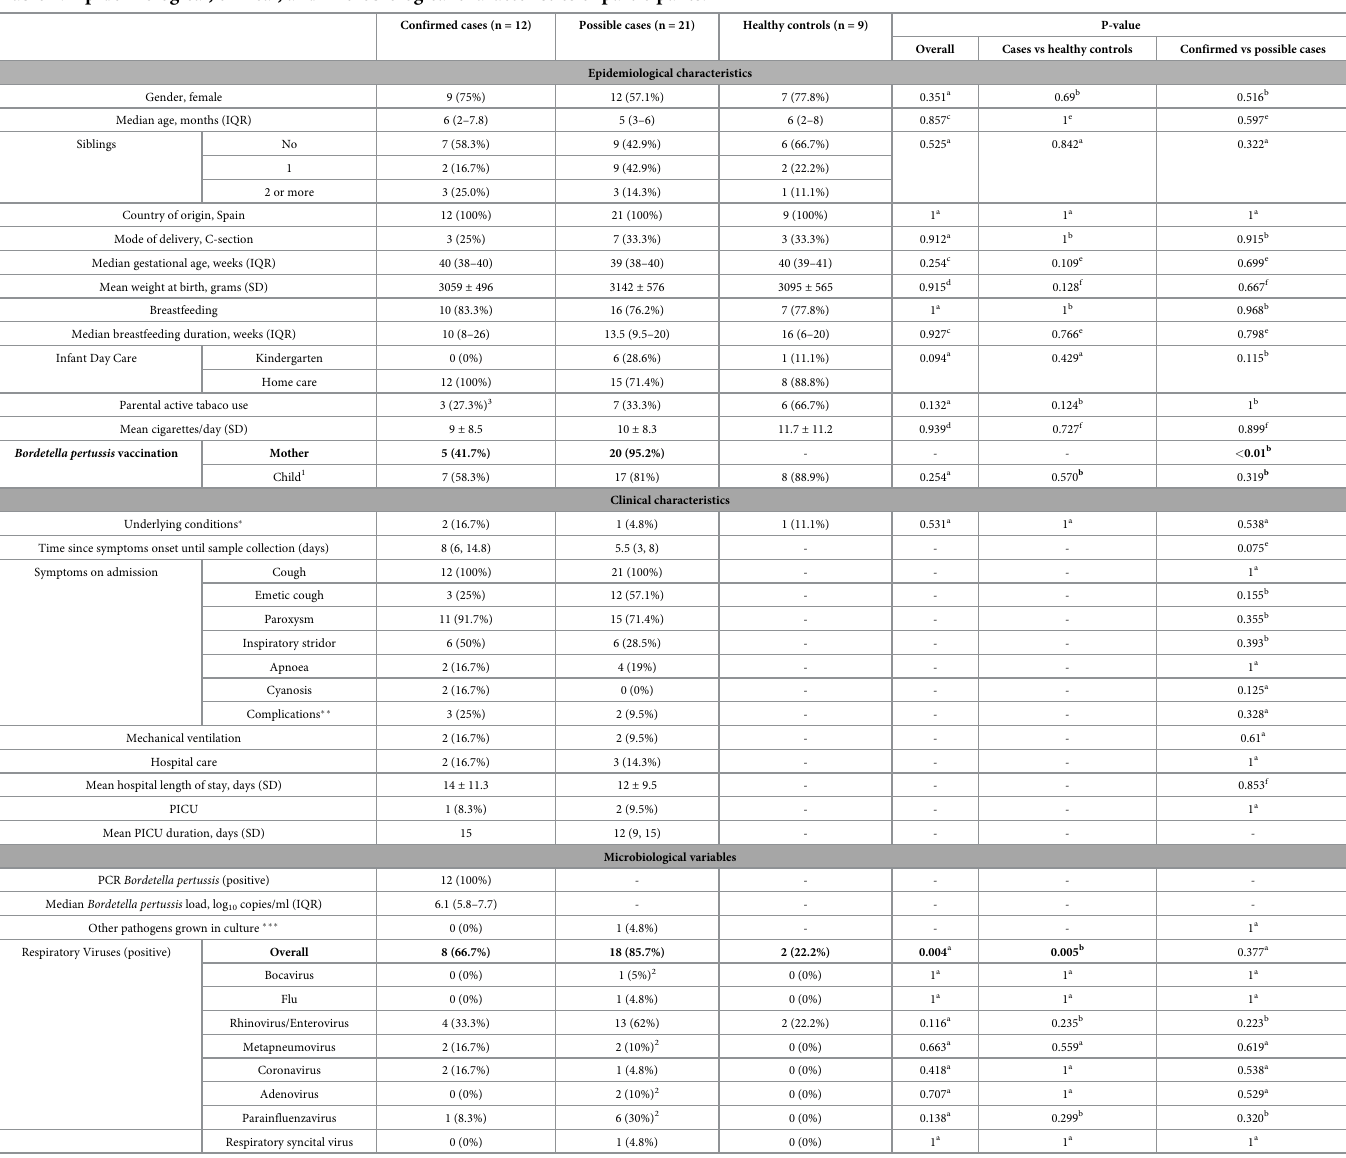
Table 1. Epidemiological, clinical, and microbiological characteristics of